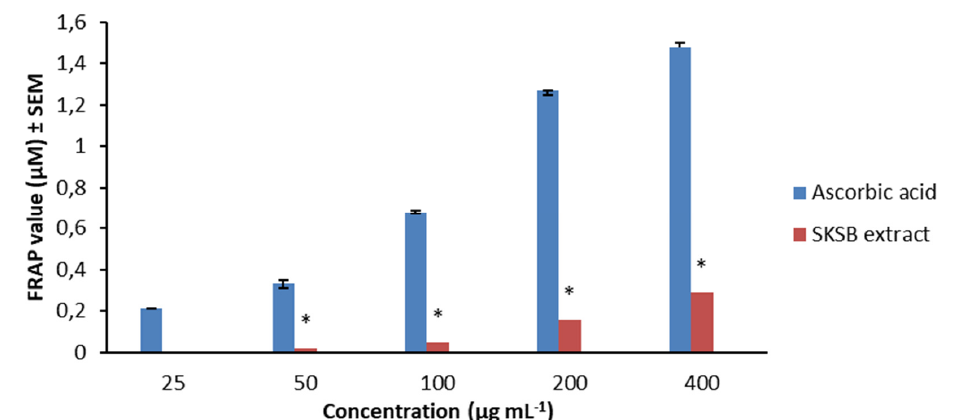
Figure 2. FRAP test with S. kunthianum extract *Significantly (P < 0.01) reduced value compared to ascorbic